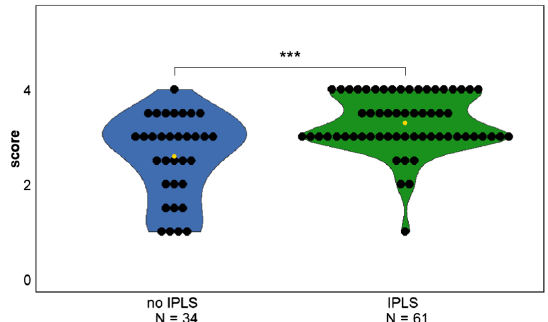
FIG. 7. Overall rubric scores for coordinating equations to physical situations from non-IPLS students (blue envelope, black dots) and IPLS students (green envelope, black dots) from parts (a) and (b) of the fluids task. Each student ’ s score is represented by a black dot, and the median score is represented by a yellow dot. *** indicates p < 0 . 001